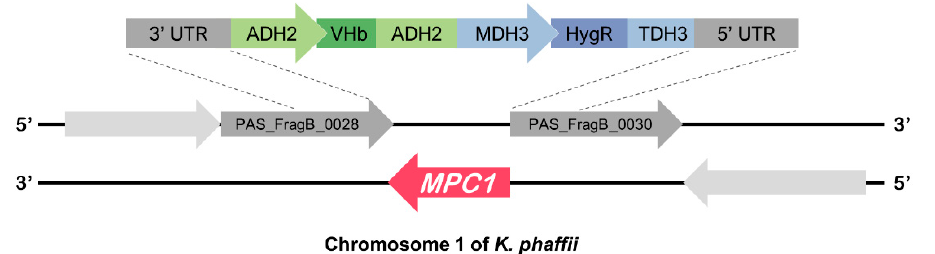
Figure 2. The MPC1 gene of K. phaffii is located in the complementary strand of chromosome 1. The disruption cassette with 700 bp region of homology flanks the MPC1 gene in the K. phaffii genome. The brown areas in both schemes are the homology flanks that drive the recombinational knock-in of the cassette into the locus. Table 1. Strain, plasmid, and primers used in this